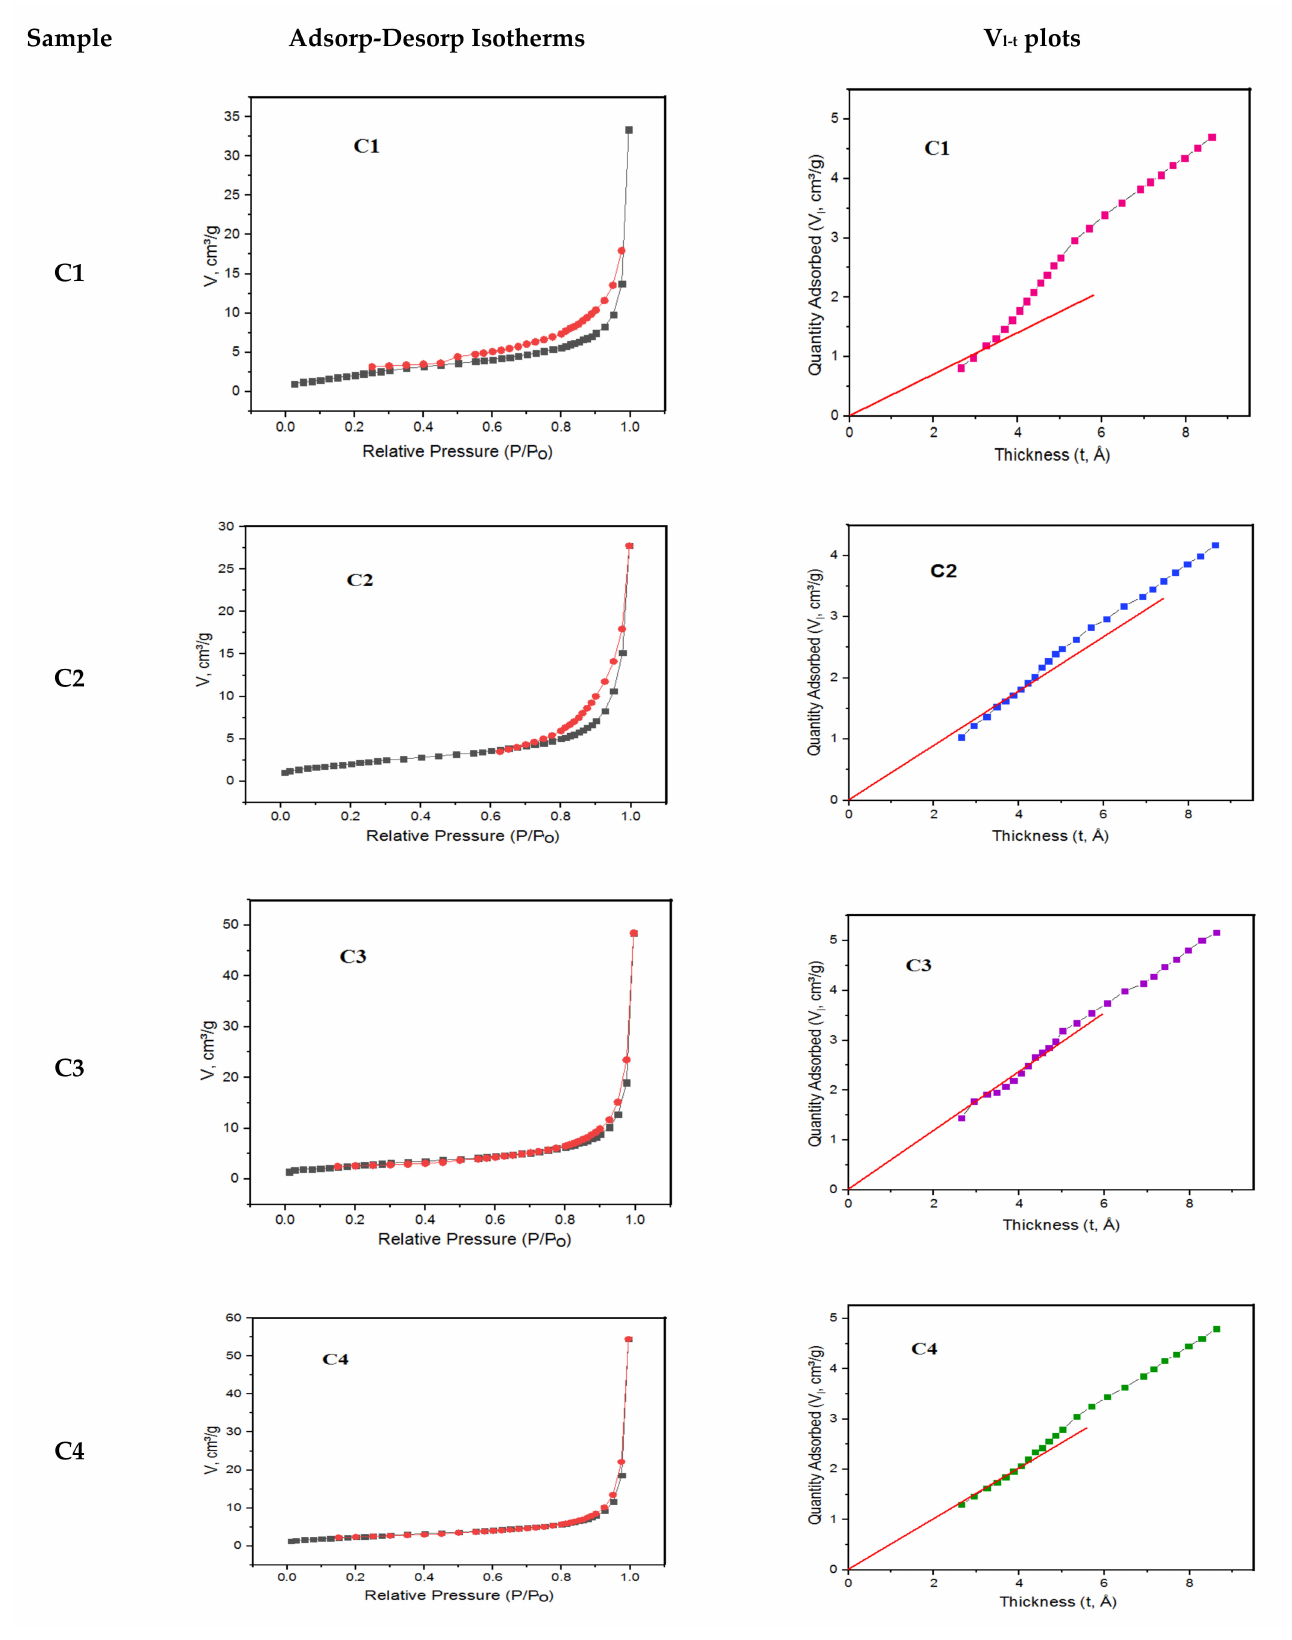
Figure 8. N 2 -adsorption/desorption isotherms and V l-t plots of the C1 , C2 , C3 , and C4